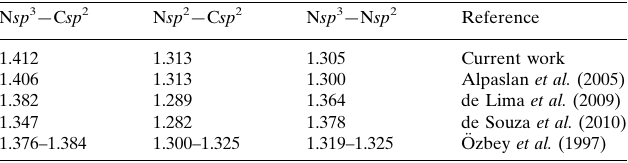
Selected bonds compared with related hydrazone compounds (A˚